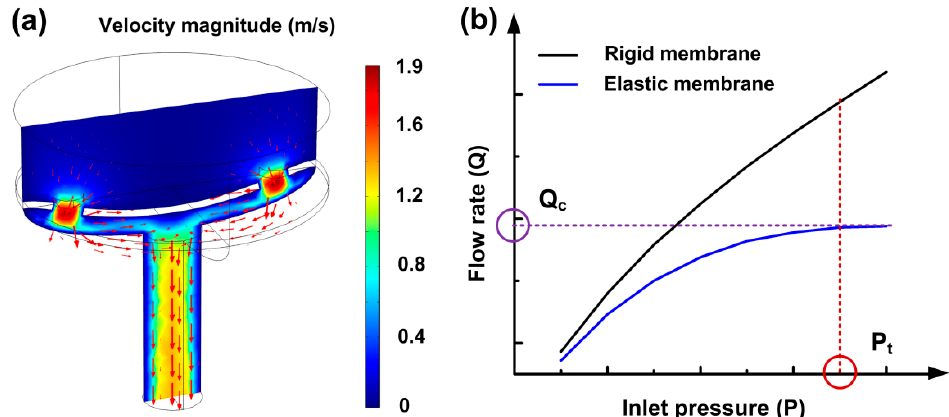
Figure 2. Fluid-Structure Interaction simulation of valve actuation. ( a ) Simulated velocity magnitude in the valve. ( b ) Simulated flow rate versus the inlet pressure in the valve.